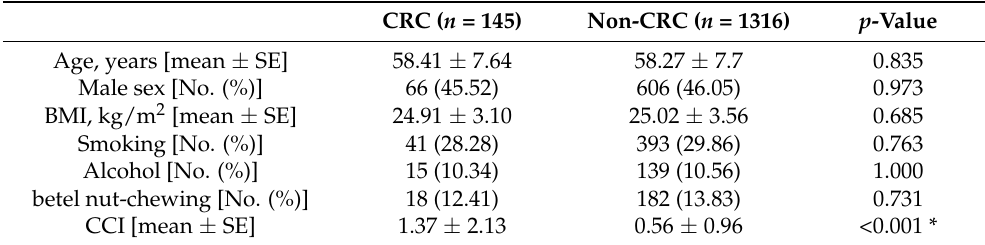
Table 1. Demographic and clinical characteristics of study